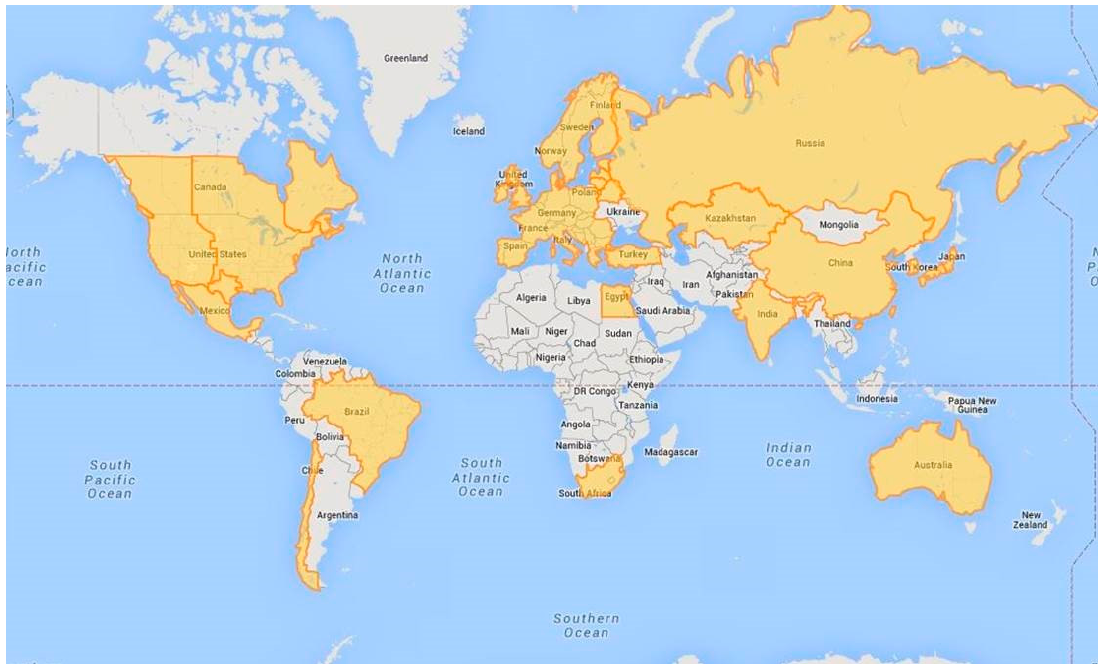
Figure 1. FNET/GridEye sensor deployment in North America. The red point shows the frequency disturbance recorder (FDR) location.